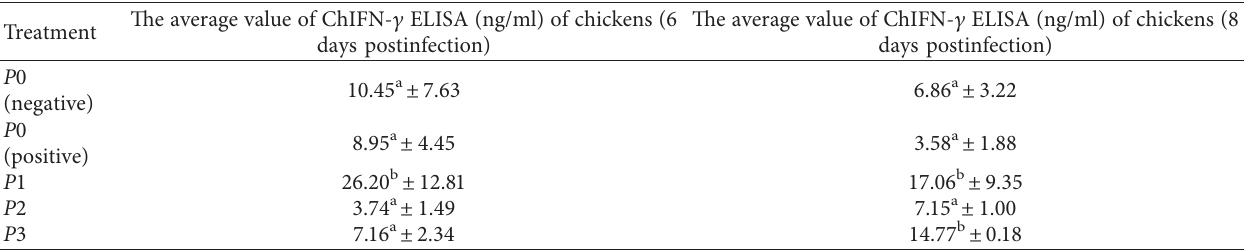
Table 1: The average value of ChIFN- c ELISA (ng/ml) in the blood serum of chickens (6 and 8 days postinfection) infected with E . tenella . The average value of ChIFN- c ELISA (ng/ml) of chickens (6 Treatment